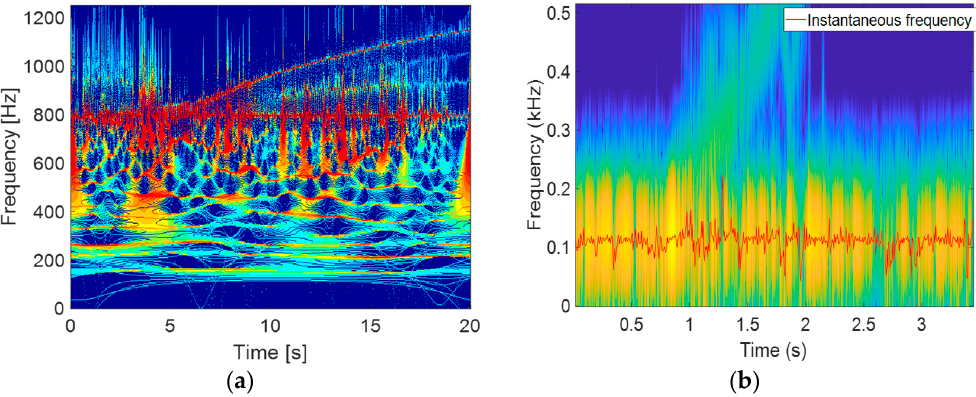
Figure 10. Time–frequency map of rotor-stator contact; ( a ) WSST response; ( b ) IF response.